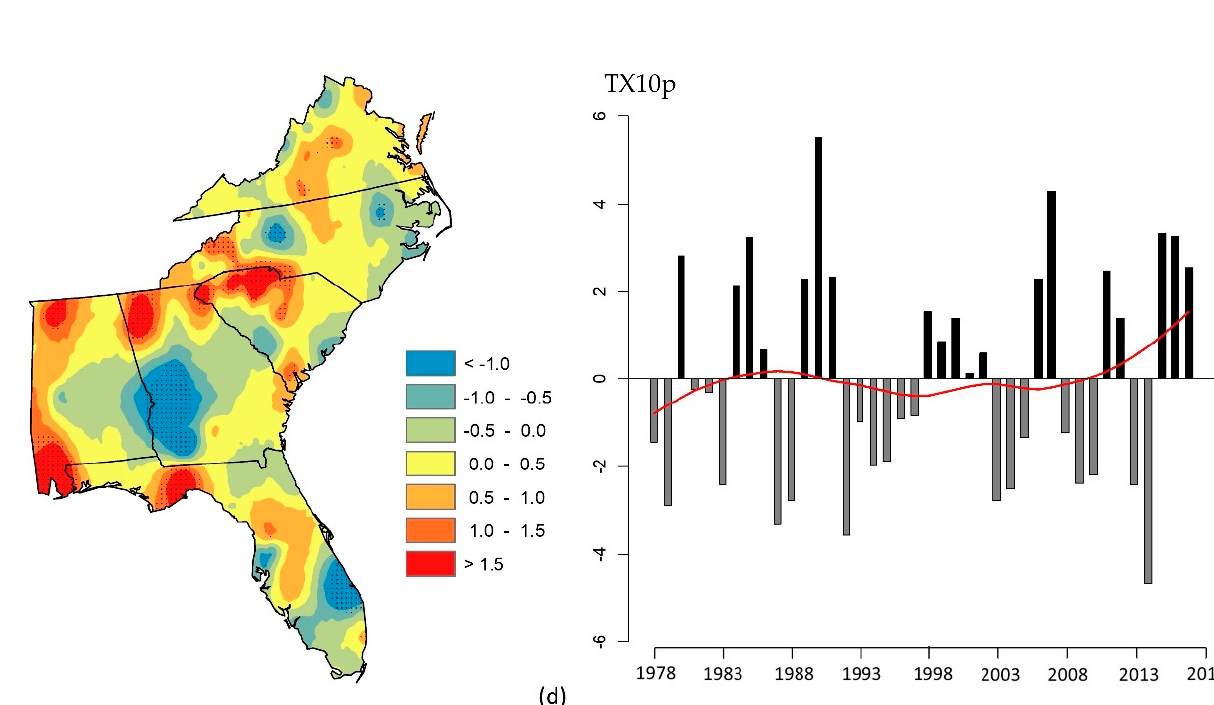
Figure 5. Spatial distribution of trends (in days per decade for 1978–2017) and associated annual time series anomalies (in days) for percentile-based indices: ( a ) cool nights (TN10p); ( b ) cool days (TX10p); ( c ) warm nights (TN90p); ( d ) warm days (TX90p). Stippled areas on the maps indicate trends that are significant at the 5% level. The red line in the plots is a smooth curve fitted to the time series data using the loess method.